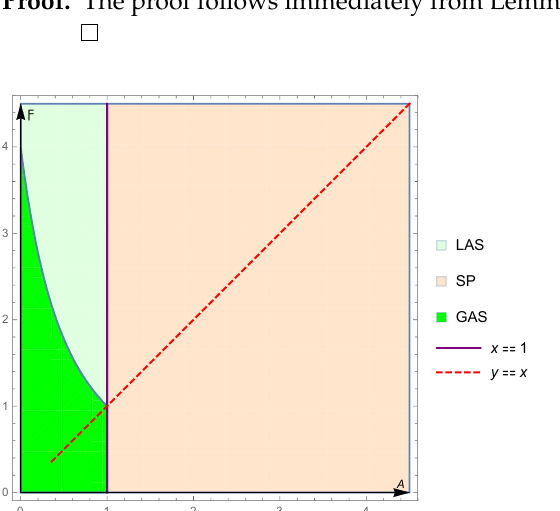
Figure 4. The area of the global asymptotic stability proved by Theorems 8, 9 and 11.